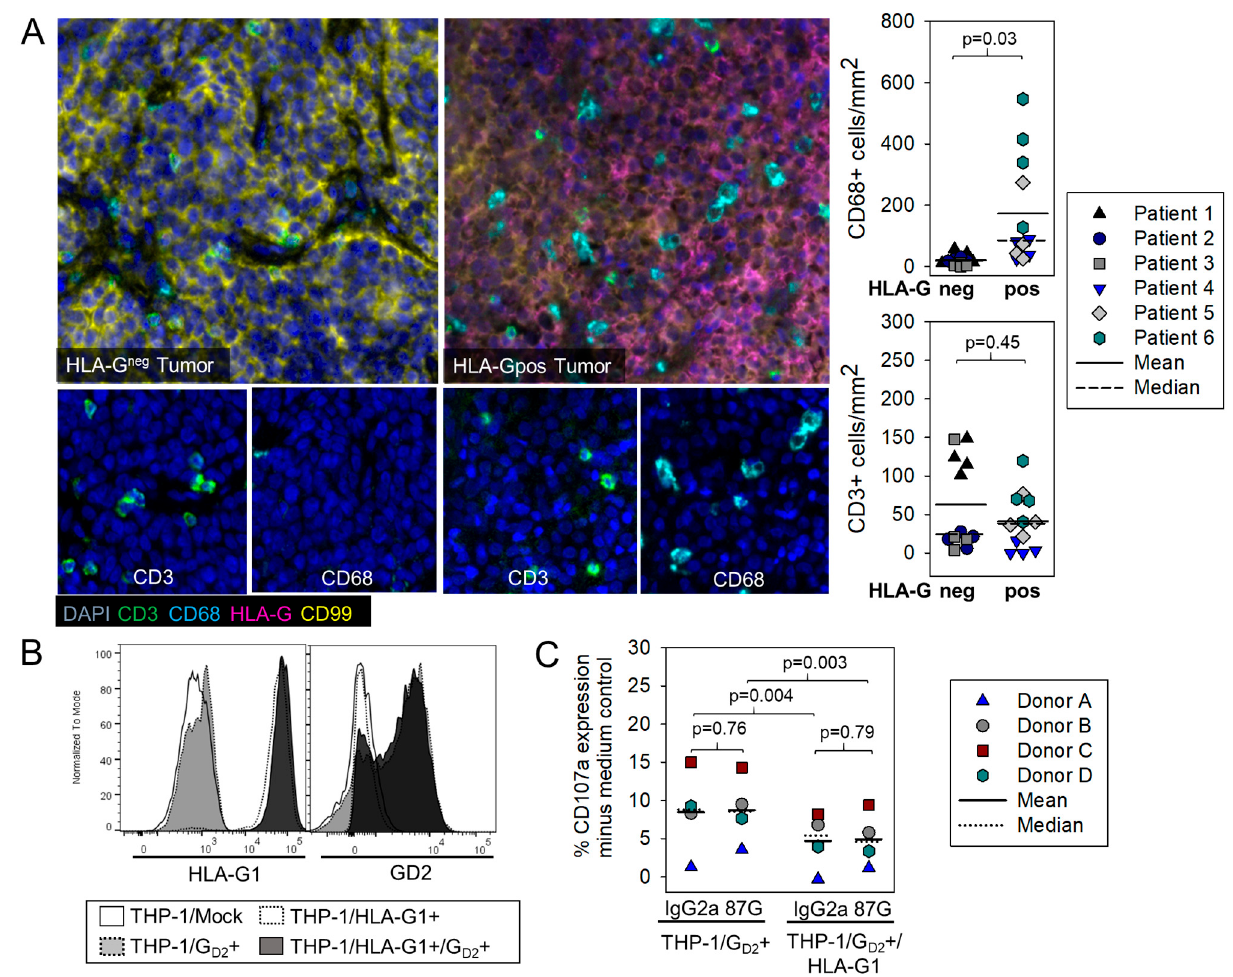
Figure 3. HLA-G1 expression in EwS is associated with the presence of myeloid cells, and HLA-G1 expressed by THP-1 monocytic cells reduces the degranulation response of CAR gene-modified effector T cells. ( A ) Representative multiplex immunofluorescence staining (20×) of HLA-G-negative (left panel) and HLA-G-positive (middle panel) human EwS biopsies with antibodies against CD3, CD68, HLA-G, CD99 and DAPI, as indicated. Scatter plot analysis of CD3+ T cell and CD68+ myeloid cell infiltration in HLA-G-positive and HLA-G-negative EwS biopsies (right panel). Immune cell densities (cells/mm 2 ) were analyzed in 3 patients and in 4 areas per patient. We applied a generalized linear mixed model to compare HLA-negative and -positive patients with respect to CD68 and CD3 expression, respectively. Due to skewed distributions of expression values, a negative-binomial distribution with a log-link function was used. Repeated measurements per patient (i.e., areas) were modelled by a variance components-type covariance matrix. Wald-test p -values are reported for the group comparison. ( B ) HLA-G1 and G D2 coexpression on THP-1 cells after retroviral gene transduction with HLA-G1 and GD3S/GD2S genes. ( C ) CD107a expression of CD85j+ GD2.BB ζ CAR-transduced T cells from 4 individual healthy donors, after coincubation with HLA-G1- and GD3S/GD2S-transduced THP-1 cells, with and without preincubation (30 min), with HLA-G1-specific blocking antibody clone 87G (20 μ g/mL) or IgG2a control. THP-1 cells transduced only with the GD3S/GD2S transgene for G D2 target expression (HLA-G1-neg) were used as controls. Statistical analysis was performed with one-way repeated measures ANOVA.